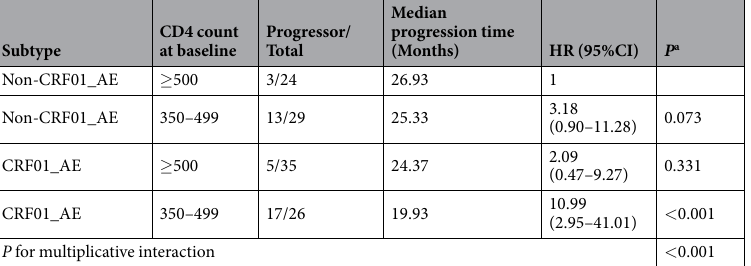
Table 4. The interaction between HIV-1 subtypes and CD4 count at baseline on HIV/AIDS progression. a P value of interaction analysis between HIV-1 subtype and CD4 count at baseline on HIV/AIDS progression with adjustment for gender, age at infection and transmission